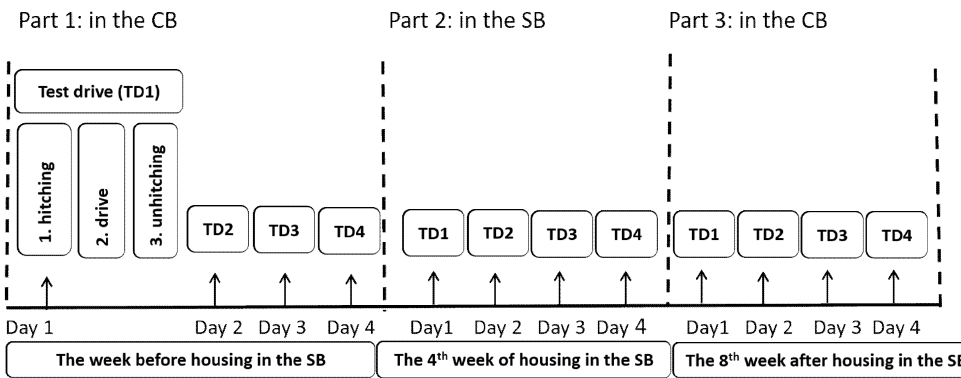
Figure 1. Experimental procedure. The black dotted line indicate the housing system of the stallions at the time during which they were observed (before, during and after being housed in social box). The black arrows indicate the different days during which the drive tests were performed. “CB” is the abbreviation for conventional box, “SB” for social box.